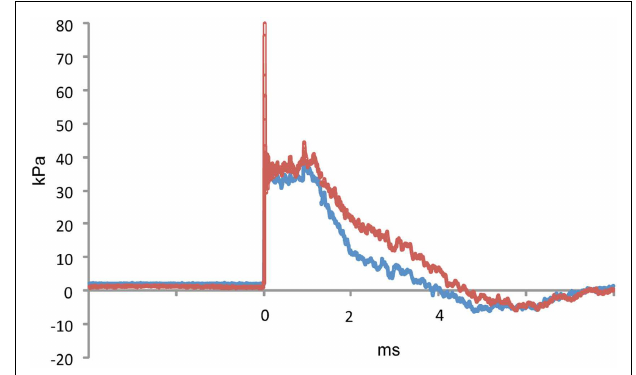
FIGURE 1 |A representative tracing of a 36.6kPa blast wave exposure is shown. The red line indicates dynamic pressure and the blue line static pressure.The blast overpressure duration (ms) was 4.1 ± 0.3 (SEM) and the overpressure integral (kPa*ms) was 75.2 ± 4.5. Characteristics of the 74.5 and 116.7kPa blast waves can be found in Ahlers et al.